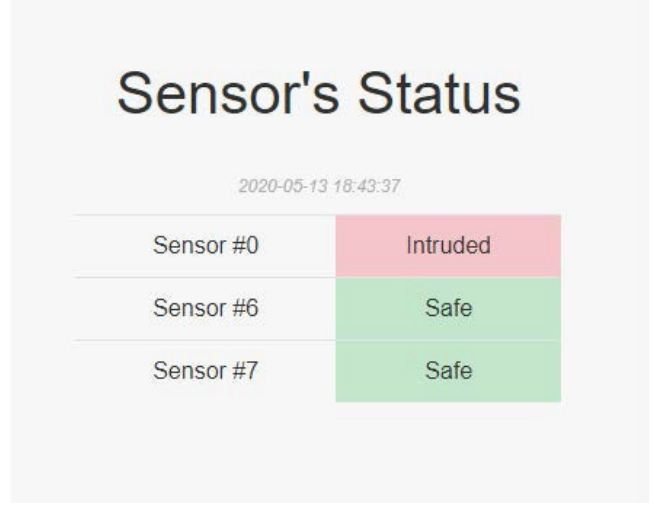
Figure 25. Sensor status.